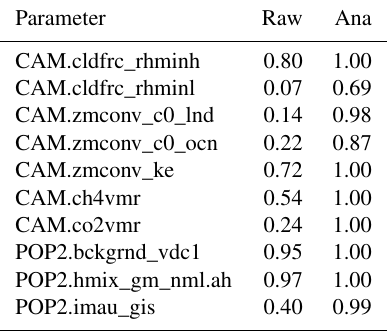
Table 4. CESM experiment. P values of Shapiro–Wilk normality test for the ensemble of original control variables (Raw) and trans- formed by Gaussian anamorphosis